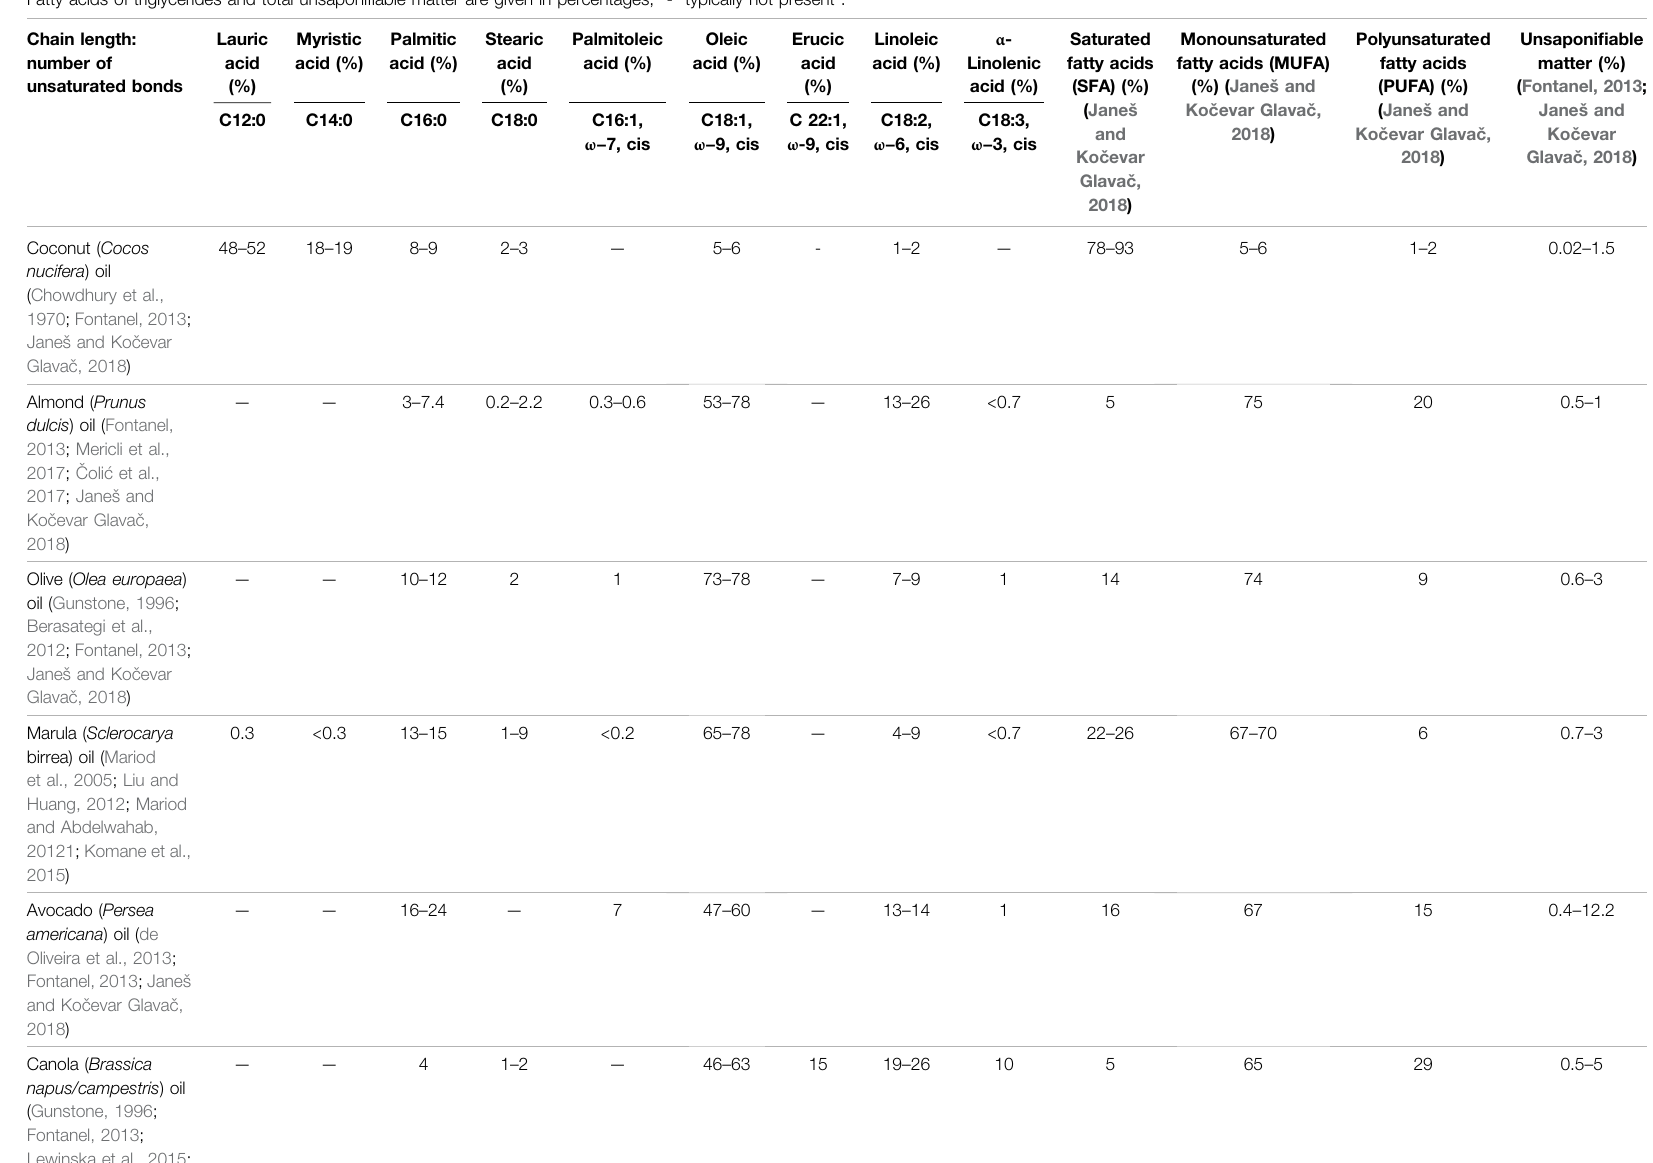
TABLE 1 | Vegetable butters and oils, their fatty acid composition and unsaponi fi able matter content; individual fatty acids were only included in the table when their content was at least 10% in at least one of the listed oils. Fatty acids of triglycerides and total unsaponi fi able matter are given in percentages, “ - ” typically not present*. Chain length: number of unsaturated